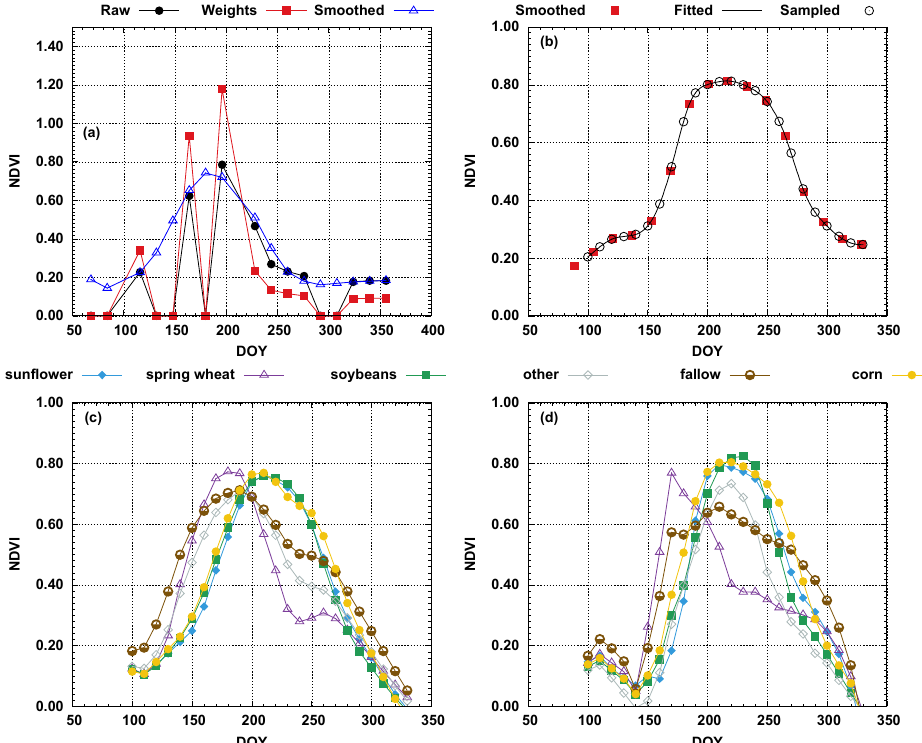
Figure 4. Filtering of the raw NDVI temporal sequences using a weighted least-squares method [38] ( a ). The filtered curves were re-sampled to address data dimensionality di ff erences at constant 10-day intervals ( b ). Average resampled curves for 2000 ( c ) and 2005 ( d ) for the six classes considered: (1) sunflower, (2) spring wheat, (3) soybeans, (4) corn / maize, (5) other crops, and (6) fallow, idle, grassland, and all other